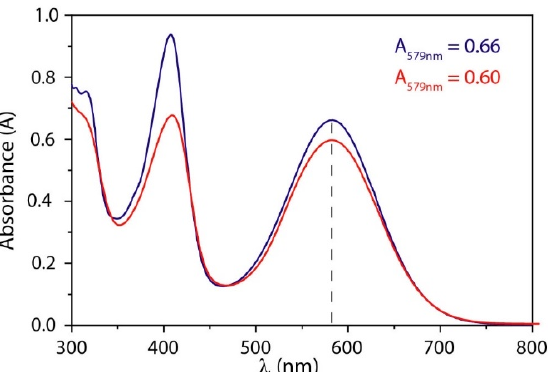
Figure 3. Absorption spectra of APTES@SiO 2 (50 nm) and APTES@SiO 2 (200 nm) treated with nin-